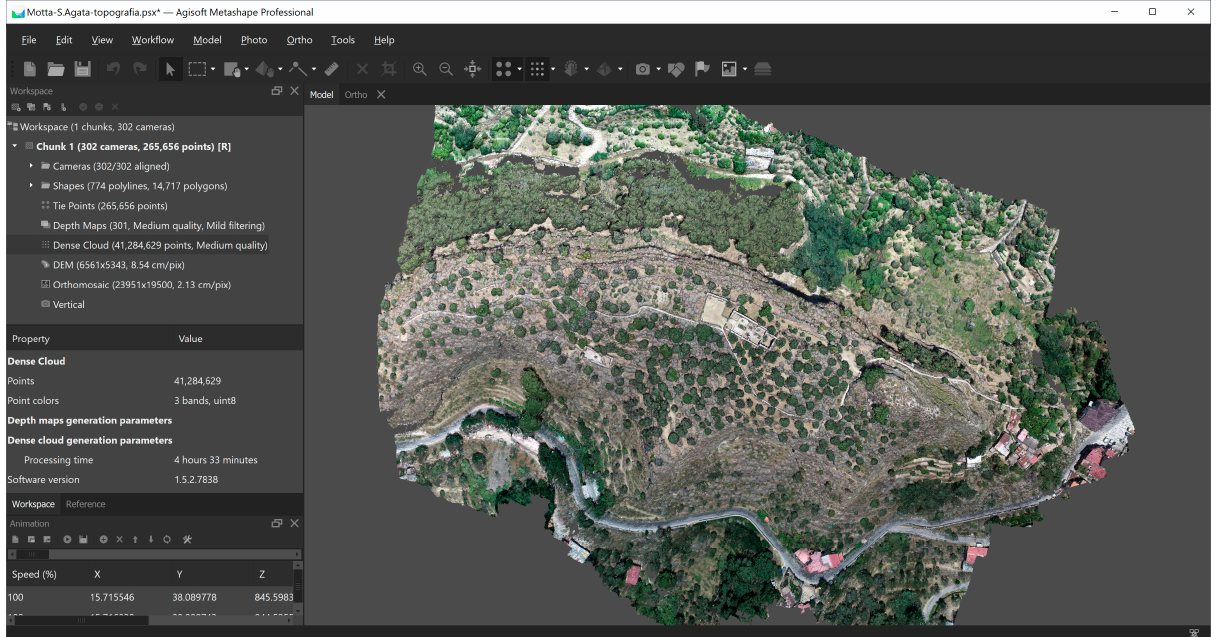
Figure 18. 3D Topographic model of the site derived from UAV photogrammetry.